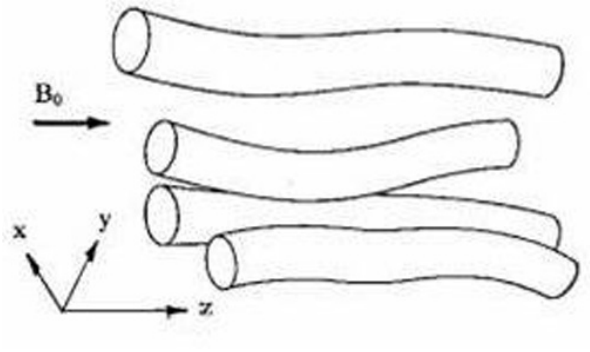
Fig. 5. Magnetic coherent vortex. Figure extracted from work of Chang et al.